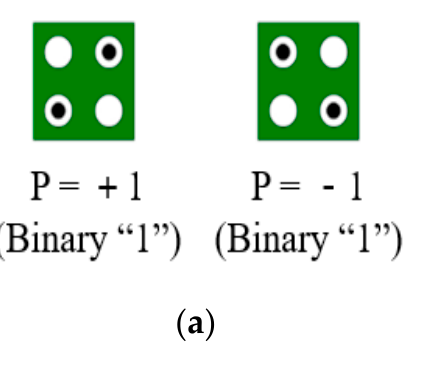
Figure 1. QCA basic concept: ( a ) two possible polarizations; ( b ) wiring.